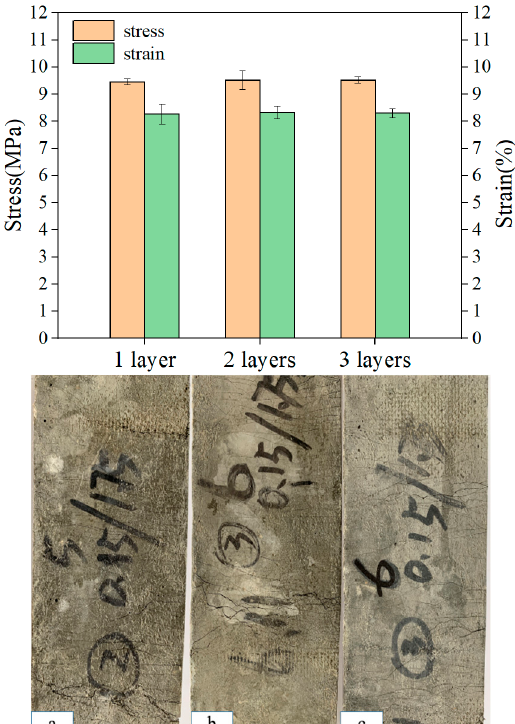
Figure 9. Stress–strain values and crack distribution in the tensile region with different arrangements: ( a ) one-layer textile, ( b ) two-layer textile, and ( c ) three-layer textile.